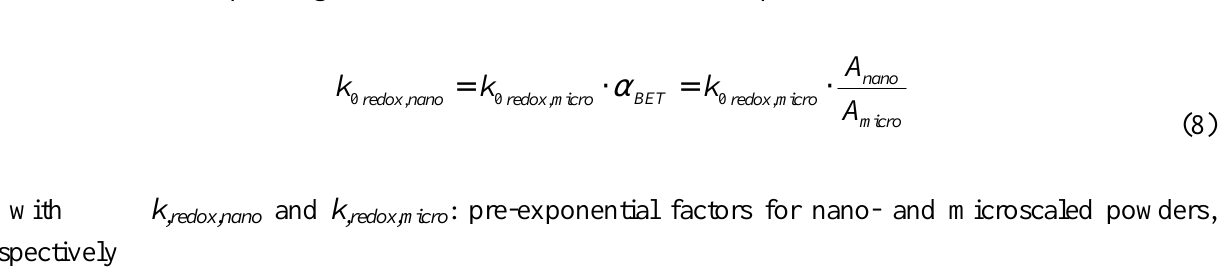
Figure 8. Dependency of the sensor response towards propane, propene, and NO on operating temperature. Gas sensitive film: SrTi thickness: 10 µm. Solid line: calculated, symbols: experimental